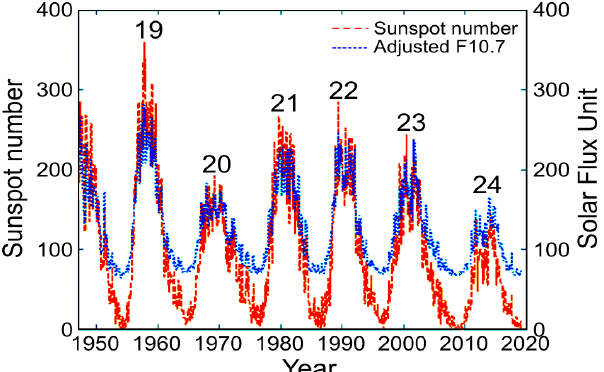
Figure 3. The sunspot numbers (red curve) and the 10.7 cm solar flux (F10.7, blue curve) from the middle of the 20th century [69–71]. The F10.7 values are in solar flux units (sfu), 1 sfu is equal to 10 –22 W m –2 · Hz –1 . The observed F10.7 is presented on the right axis.